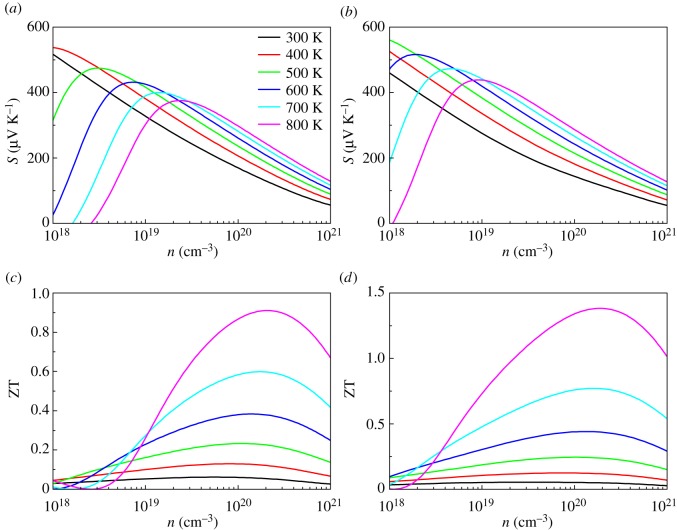
Calculated thermoelectric properties for AgX(In, Ga)Te2: (a) Seebeck coefficients for AgInTe2, (b) Seebeck coefficients for AgGaTe2, (c) thermoelectric figure of merit for AgInTe2 and (d) thermoelectric figure of merit for AgGaTe2.